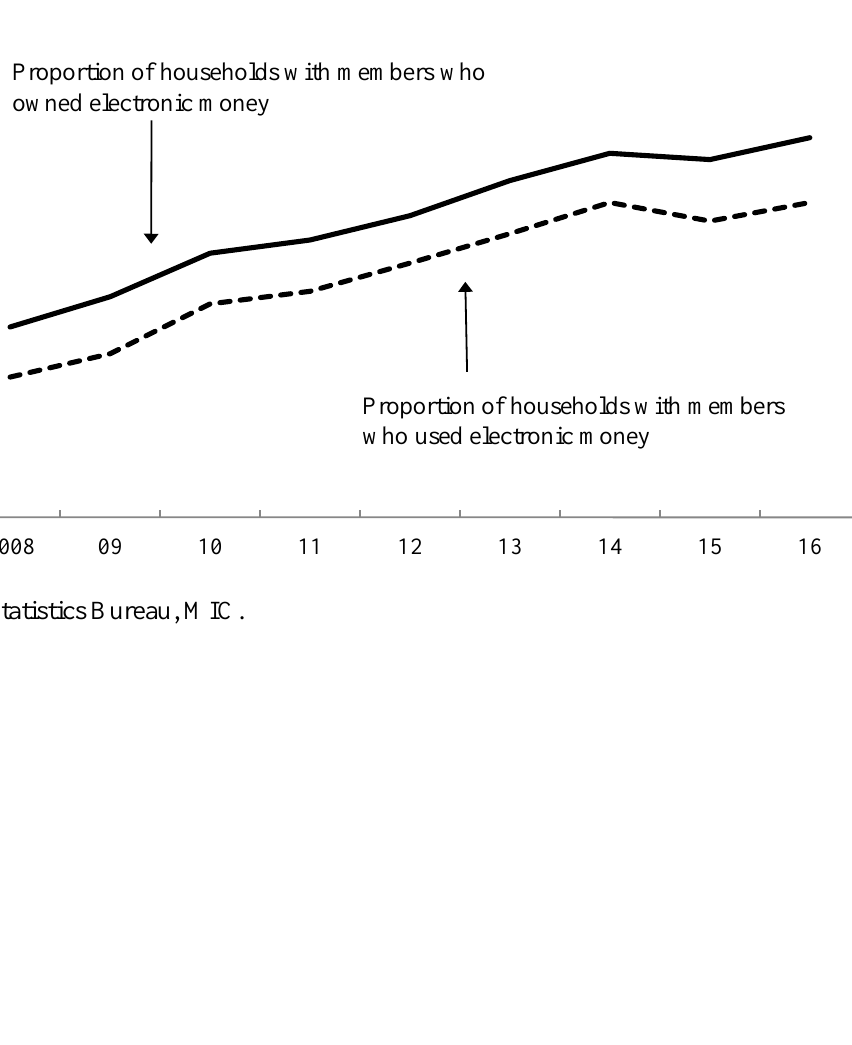
Trends in Ownership and Utilization of Electronic